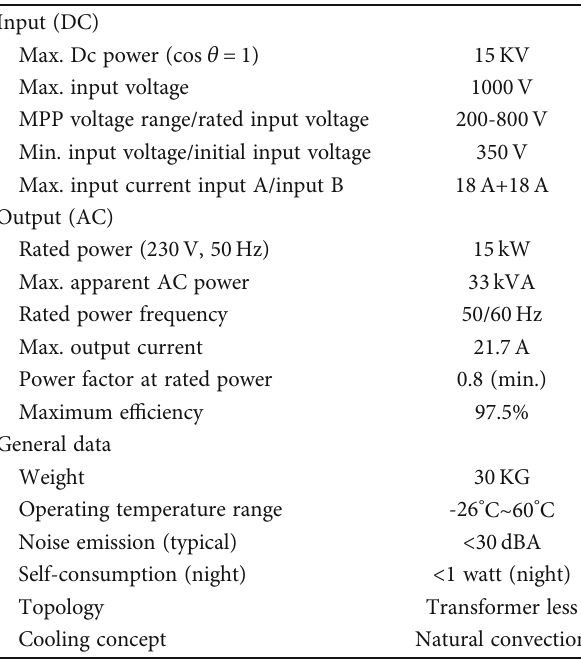
Table 2: Electrical datasheet of three-phase